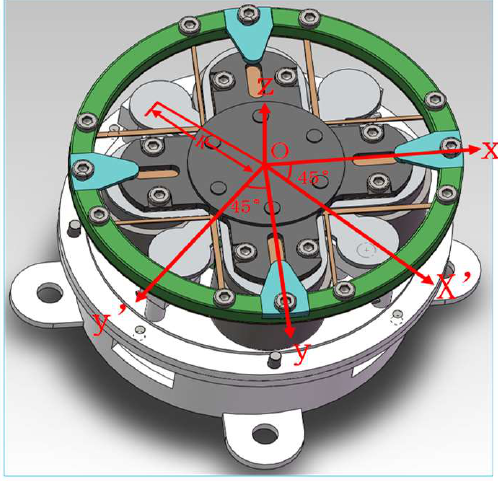
Figure 1. Structure of a fast steering mirror. When the VCA on the X-axis and Y-axis moves at a certain angle, the measured values of the eddy-current sensors on the X’-axis and Y’-axis also change correspondingly, and its coordinate system is shown in Figure 2.